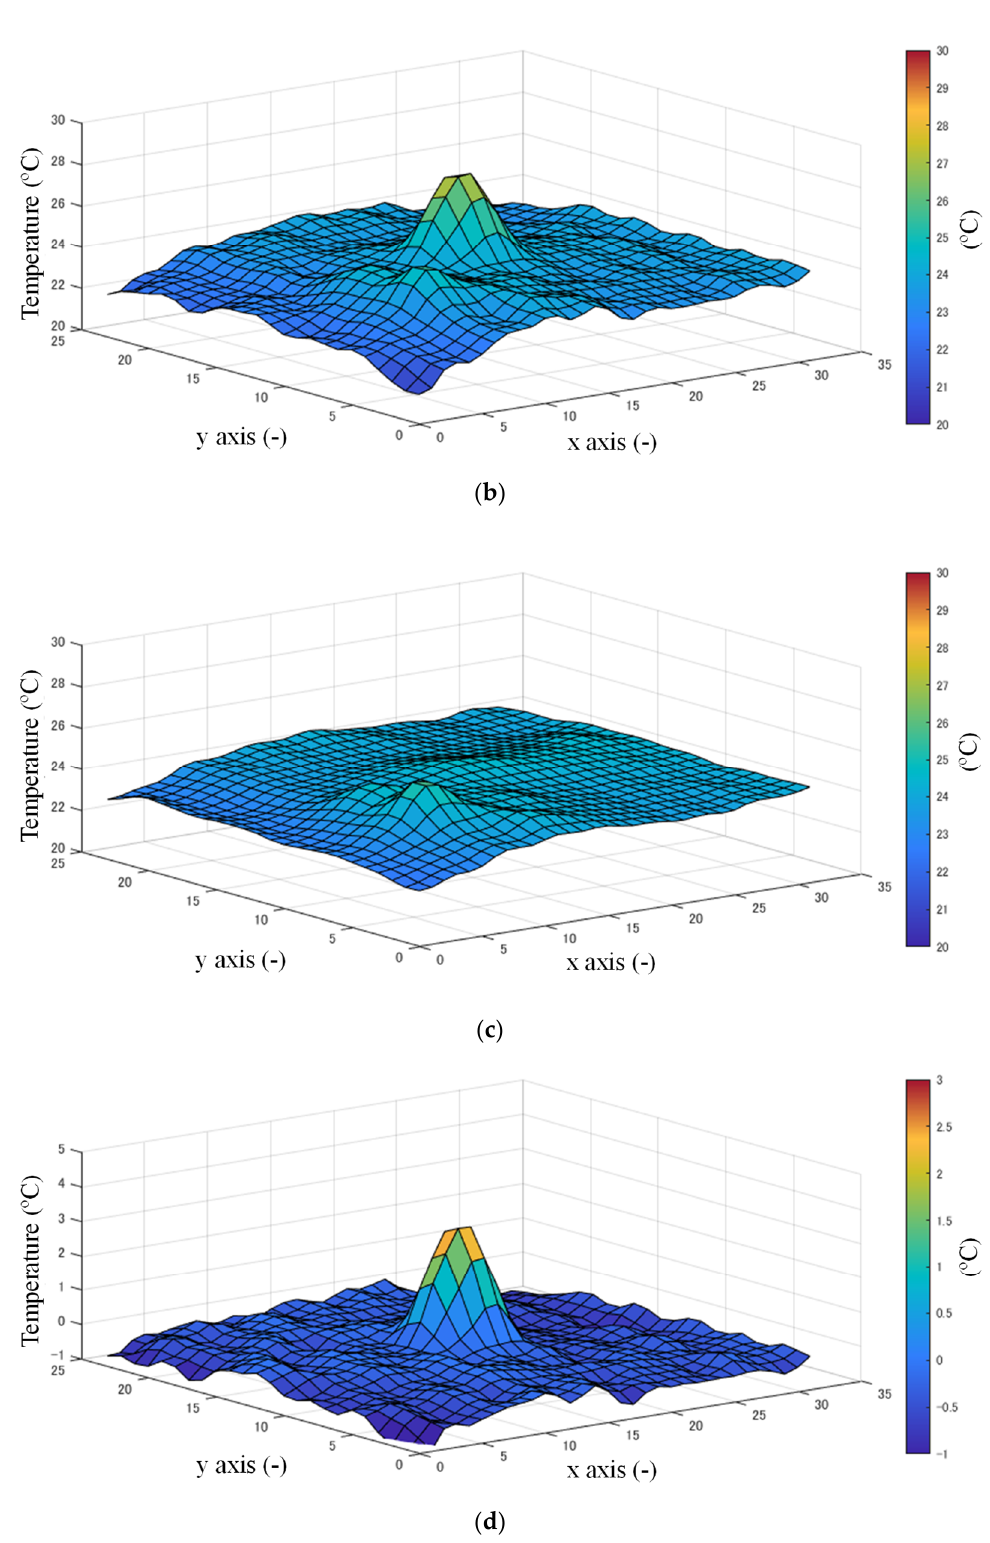
Figure 4. Example of temperature distribution: ( a ) data before Gaussian filtering; ( b ) data after Gaussian filtering; ( c ) data of background; ( d ) data after background subtraction.